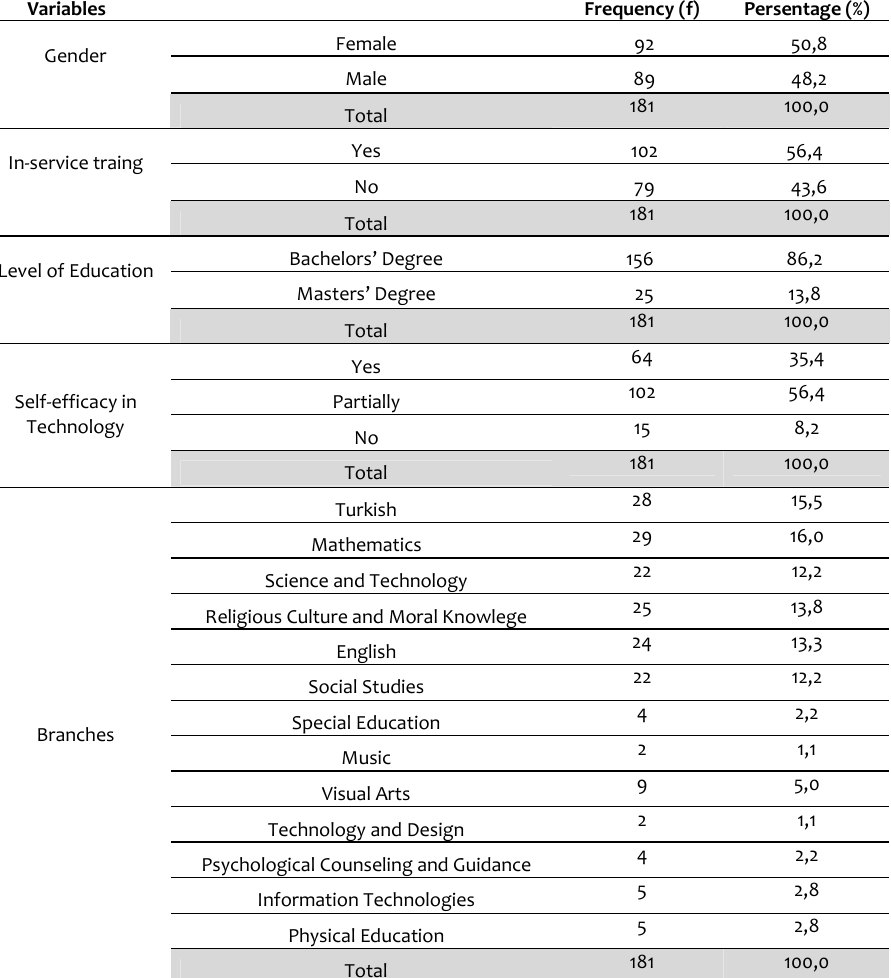
Table 1. Distribution of Secondary School Teachers According to